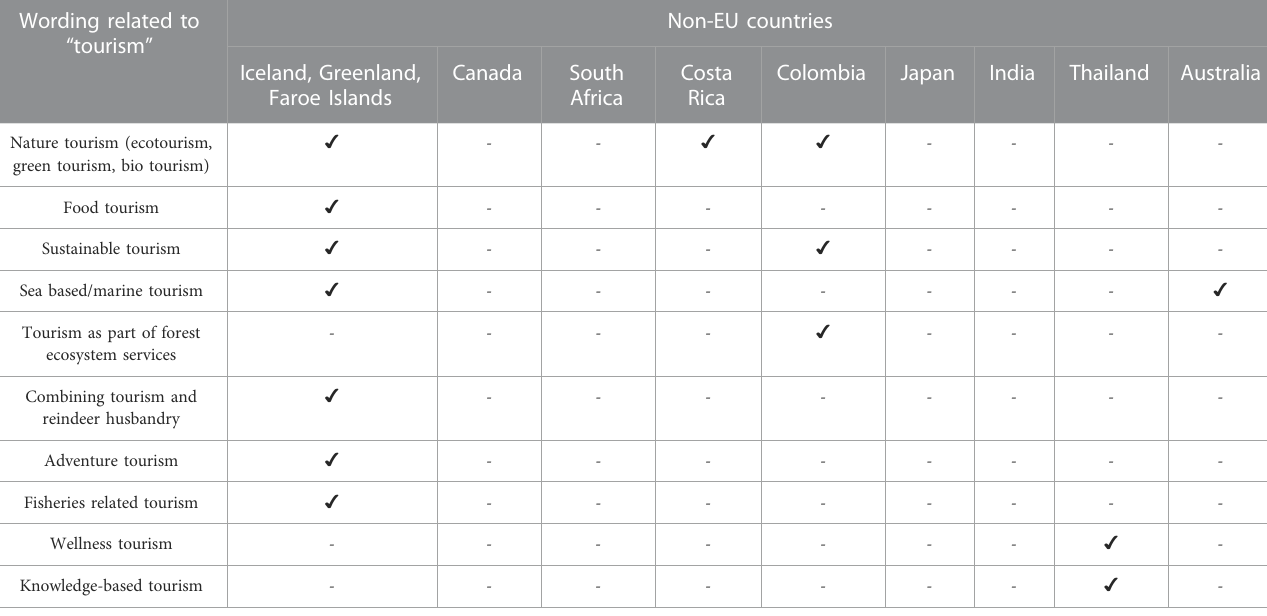
TABLE 4 Concepts of tourism in selected non-EU countries - Future Opportunities for Bioeconomy in the West Nordic Countries (NCoM, 2015); Canada ’ s Bioeconomy Strategy (BIC, 2019); The Bio-economy strategy (DoSaT, 2013); National Bioeconomy Strategy Costa Rica 2020 – 2030 (MdCITT, 2020); Bioeconomy opportunities for fourColombianregions(Ferrini,2021);Bio-Strategy2020(CO,2019);National Biotechnology DevelopmentStrategy 2021 – 2025(DoB,2021);BioeconomyinThailand: a case study (Fielding, 2018); National Science and Technology Development Agency (NSTDA, 2022); The National Marine Science Plan 2015 – 2025 (NMSC, 2015). Wording related to “ tourism